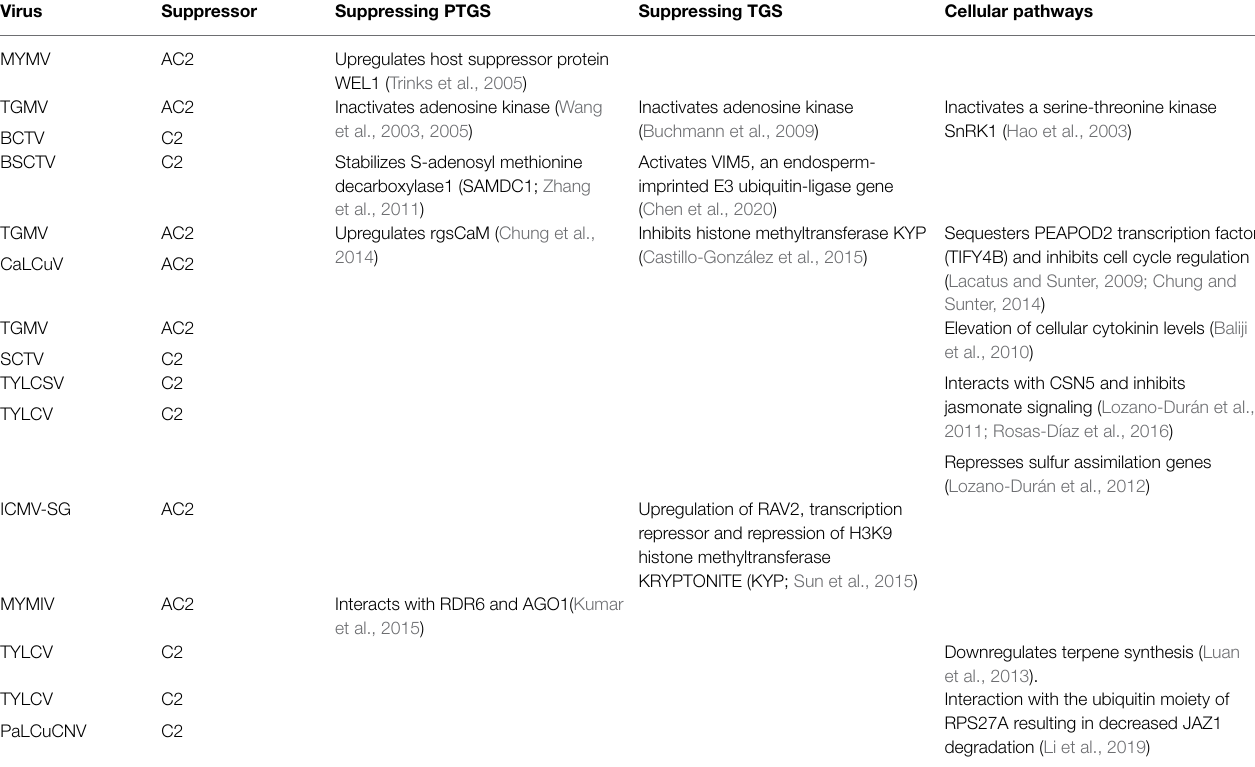
TABLE 1 | Geminivirus AC2/C2-plant protein interactions and associated functions.